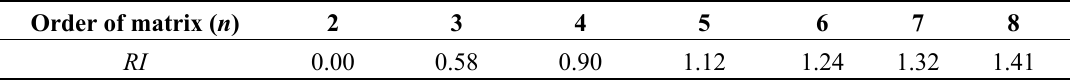
Table 1. Random index (RI)